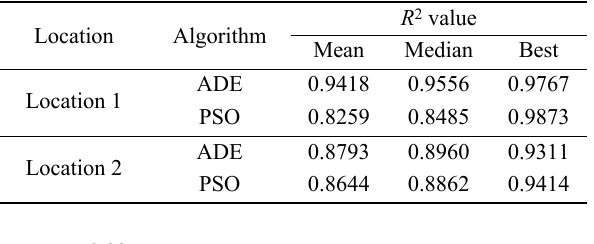
Table 6 R 2 Values for PSO and ADE using R